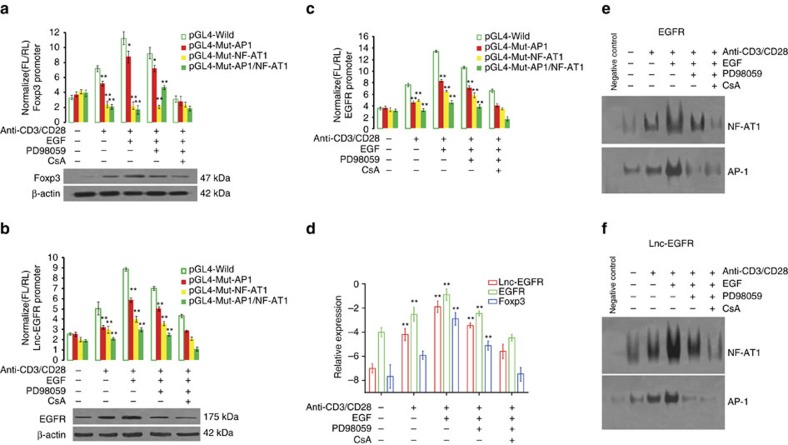
NF-AT1/AP1 complex enhances the transcription of Foxp3 lnc-EGFR and EGFR in conventional CD4+ T cells.(a–d) The binding sites for AP1 and/or NF-AT1 in the Foxp3 (a), EGFR (b), and lnc-EGFR (c) promoter regions were mutated and then cloned into the pGL4 vector; the empty vector was used as the control. CD4+ T cells were treated with TGF-β (2 ng ml−1), anti-CD3/anti-CD28 beads (bead-to-cell ratio of 1:1), EGF (20 ng ml−1), PD98059 (40 μM), and /or CsA(1 μM), and their fluorescence intensity (FL) measured by comparison with the intensity of Renilla fluorescence(n=6 for each group, Student’s t-test). Expression of Foxp3 protein was confirmed with western blotting in the lower panel and its mRNA expression was confirmed with RT–PCR (d) (n=6 for each group, Student’s t-test). (e,f) Binding of specific nuclear factors was demonstrated with EMSA analysis of the promoter region of EGFR; f panel indicates lnc-EGFR. Competition experiments were performed by preincubating nuclear extracts with AP1/NF-AT1 oligonucleotides by treating with anti-CD3/anti-CD28 beads (bead-to-cell ratio of 1:1) and EGF (2 ng ml−1) in the presence or absence of PD98059 (40 μM) and/or CsA (1 μM). Each experiment was performed triplicated. Data are presented as means±s.e.m. (*P<0.05, **P<0.01).